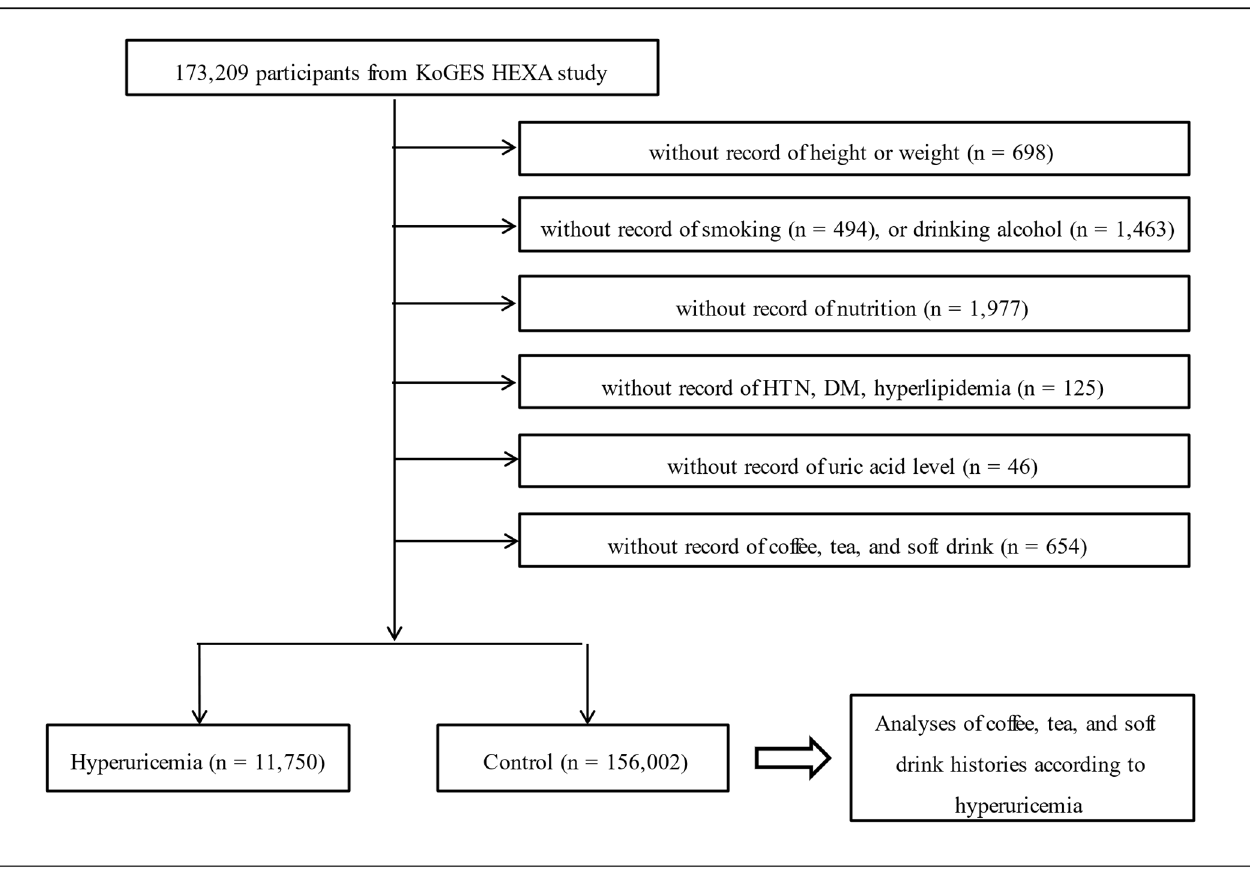
Figure 1. The selection of the study’s participants. A total of 11,750 participants with hyperuricemia and 156,002 participants with non-hyperuricemia controls were analyzed.